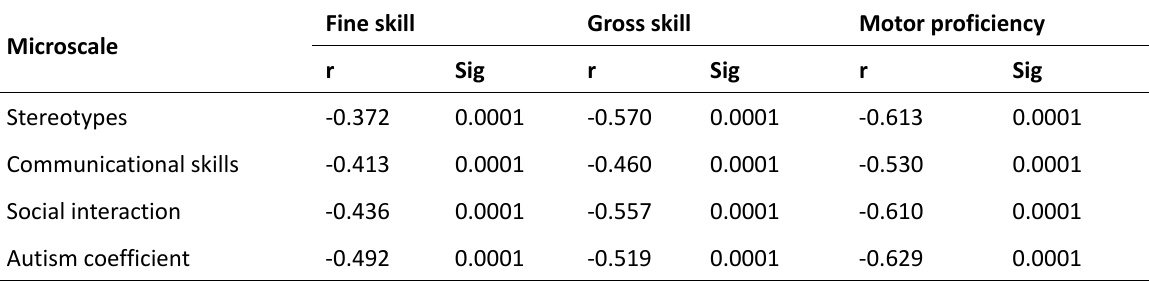
Table 2. The results of the Pearson correlation test